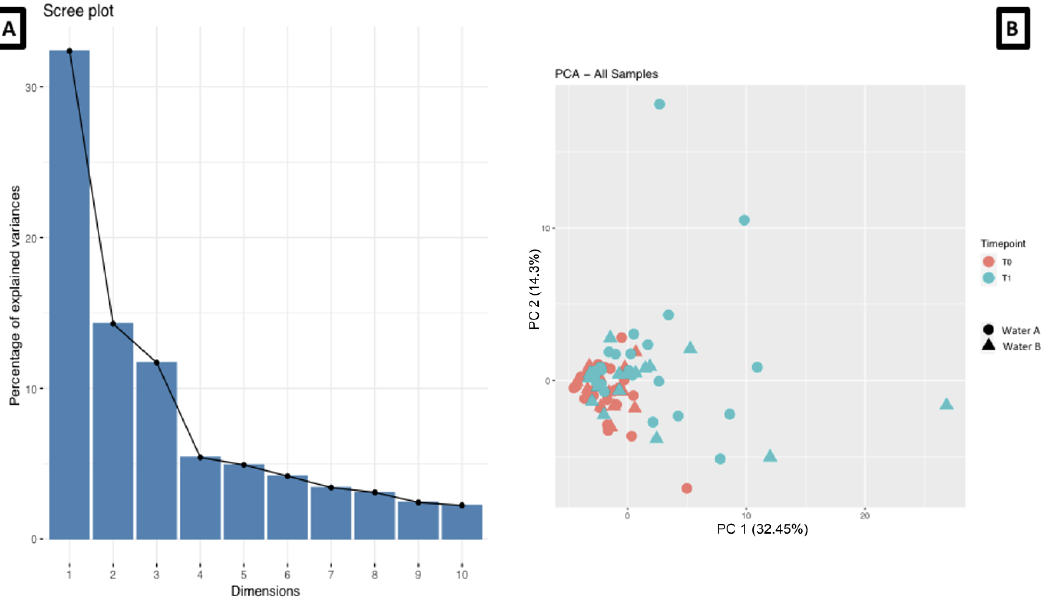
Figure 1. Cutaneous lipidomics evaluation of total variance ( A ) and representation of the two main Principal Component Analyses ( B ).